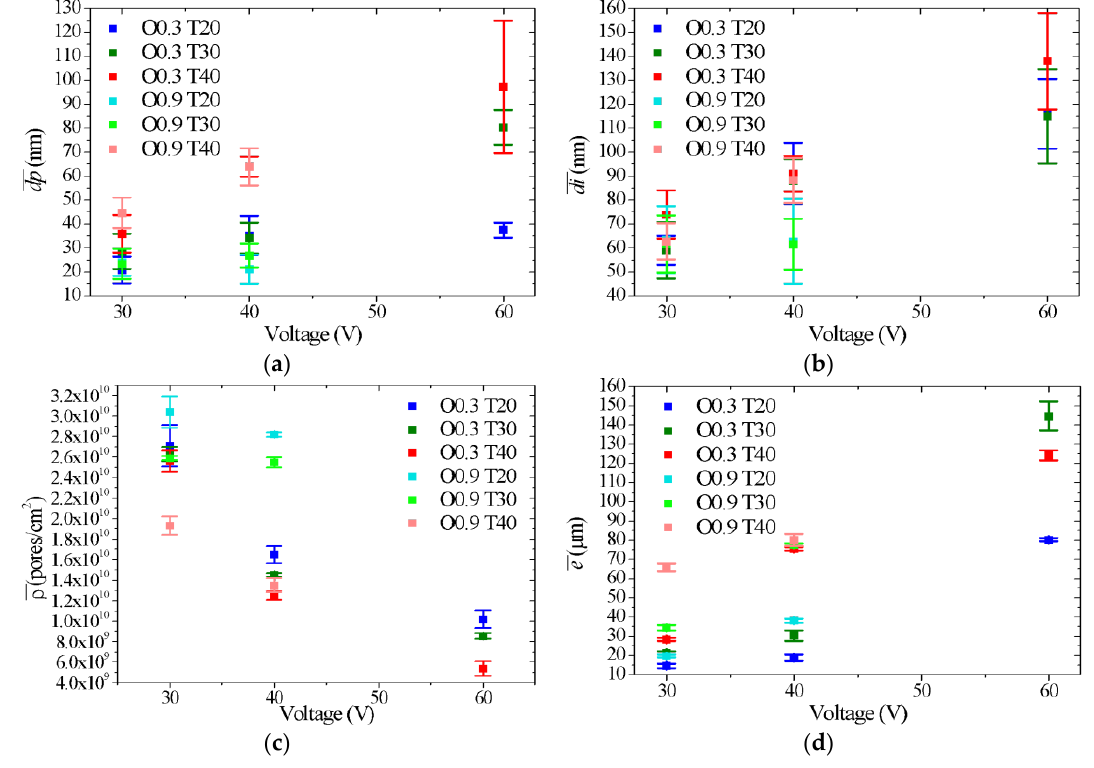
Figure 4. Variation of average pore diameter ( a ), average interpore distance ( b ), average pore density ( c ) and average thickness ( d ) of nanostructured AAO films synthesized by means of a one-step anodization process in 0.3 and 0.9 M oxalic acid as a function of voltage and temperature. Table 2. Average values of the morphological parameters of nanostructured AAO coatings obtained in 0.3 and 0.9 M oxalic acid at different temperatures and anodization voltages ( C is the oxalic acid concentration, T the electrolyte temperature, V the anodization voltage and S is the nanoporous structure).